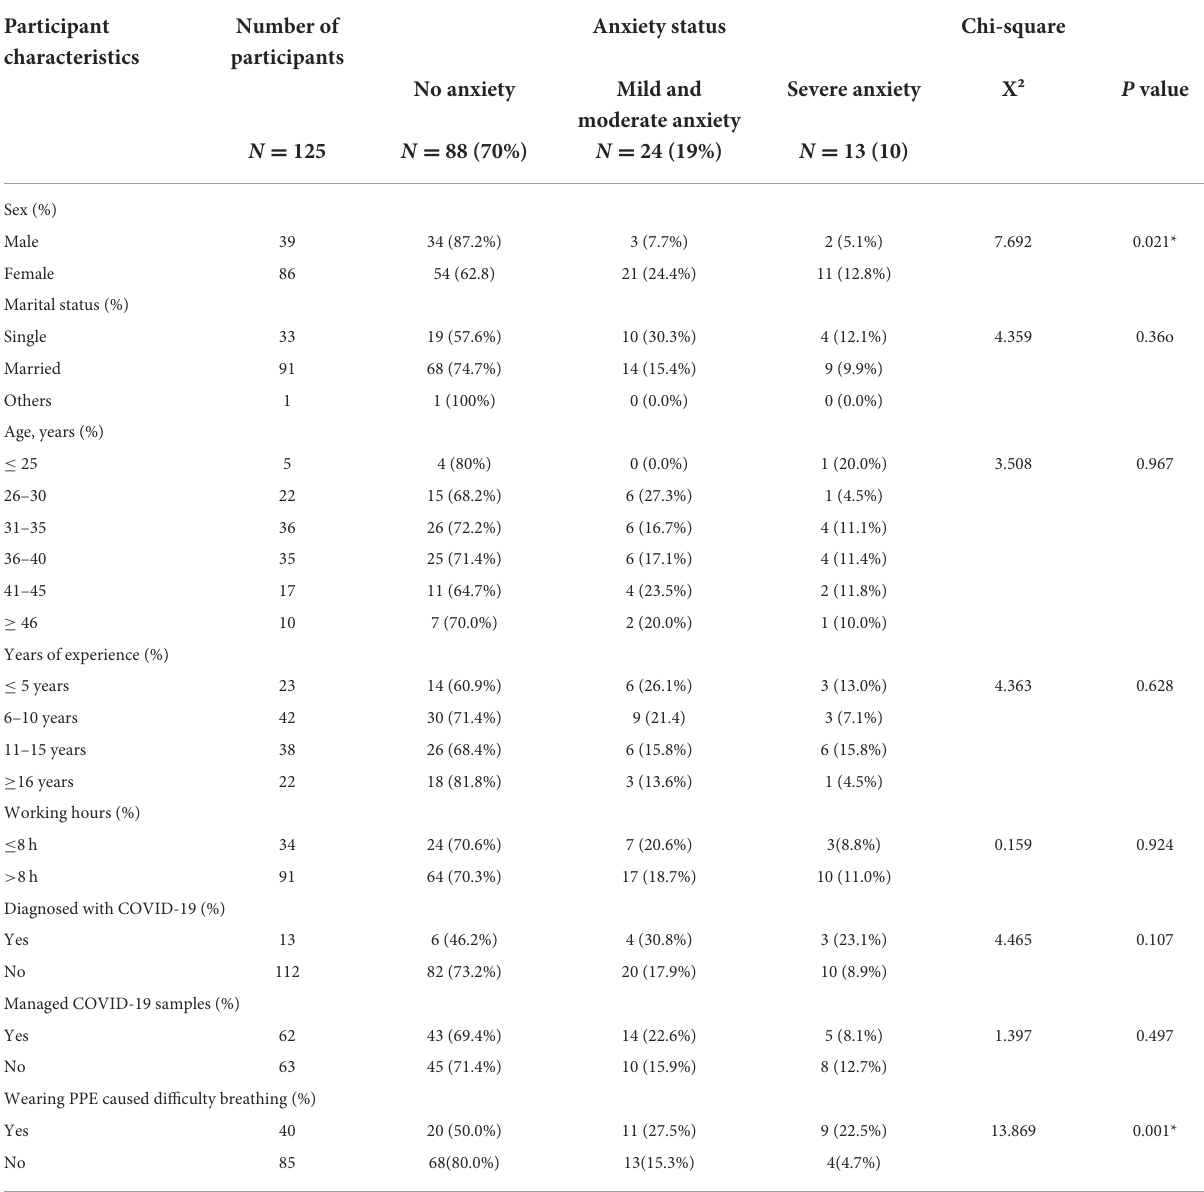
TABLE 2 Comparison of anxiety levels among participants with different demographic characteristics. Participant Number of Anxiety status Chi-square characteristics participants No anxiety Mild and Severe moderate anxiety